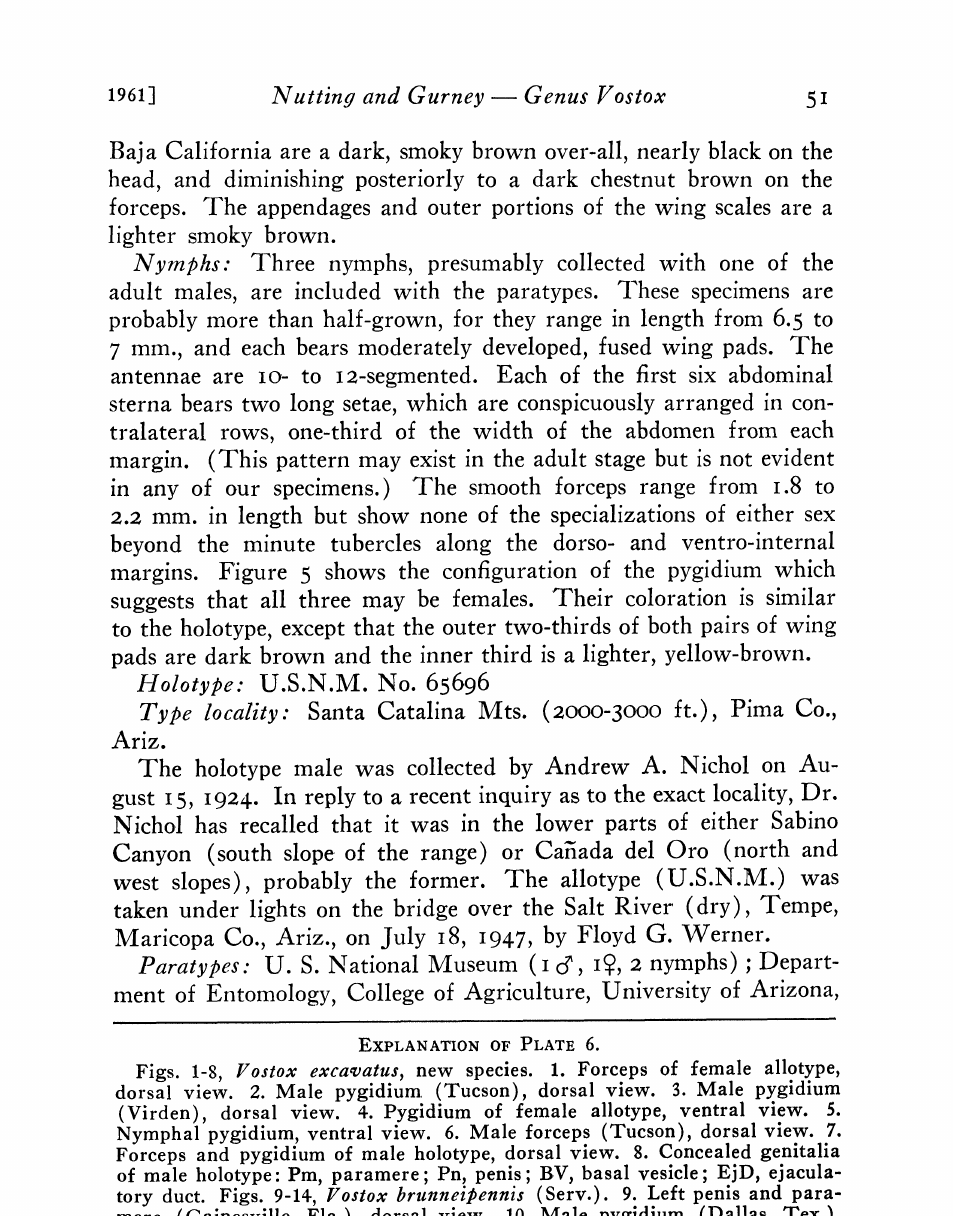
Figs. 1-8, Fostox excaatus, new species. 1. Forceps of female allotype, dorsal view. 2. Male pygidium (Tucson), dorsal view. 3. Male pygidium (Virden), dorsal view. 4. Pygidium of female allotype, ventral view. 5. Nymphal pygidium, ventral view. 6. Male foreeps (Tucson), dorsal view. 7. Forceps and pygidium of male holotype, dorsal view. 8. Concealed genitalia of male holotype" Pm, paramere; Pn, penis; B.V, basal vesicle; EjD, ejaeula- tory duet. Figs. 9-14, Fostox brunneilennis (Serv.). 9. Left penis and para- mere (Gainesville, Fla.), dorsal view. 10. Male pygidium (Dallas, Tex.), dorsal view. 11. Male pygidium (Gainesville), dorsal view. 12. Female pygidium (Paris, Tex.), ventral view. 13. Female forceps (Mobile, Ala.), dorsal view. 14. Male foreeps (Gainesville), dorsal view. Figs. 1-7, 10-14, xlS; Figs. 8 and 9, x34. (Drawings by senior